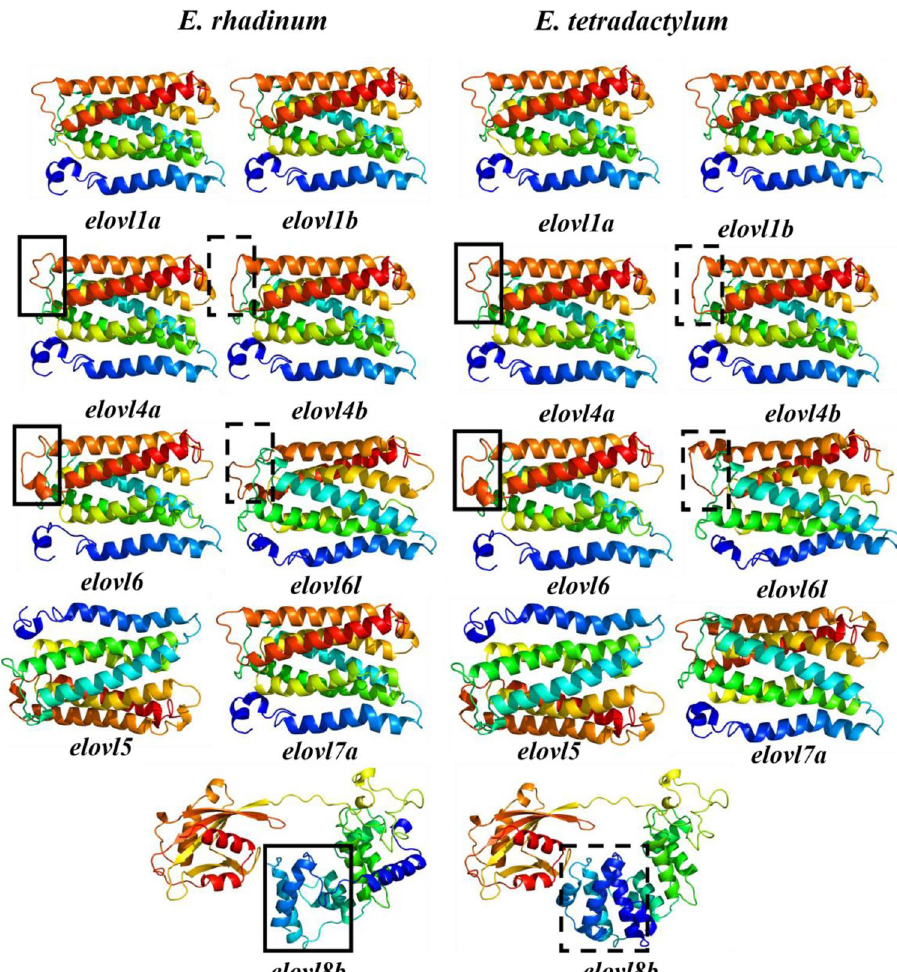
Figure 4. Three-dimensional modeling of Elovl proteins in E. tetradactylum and E. rhadinum . All models have confidence levels above 90%.